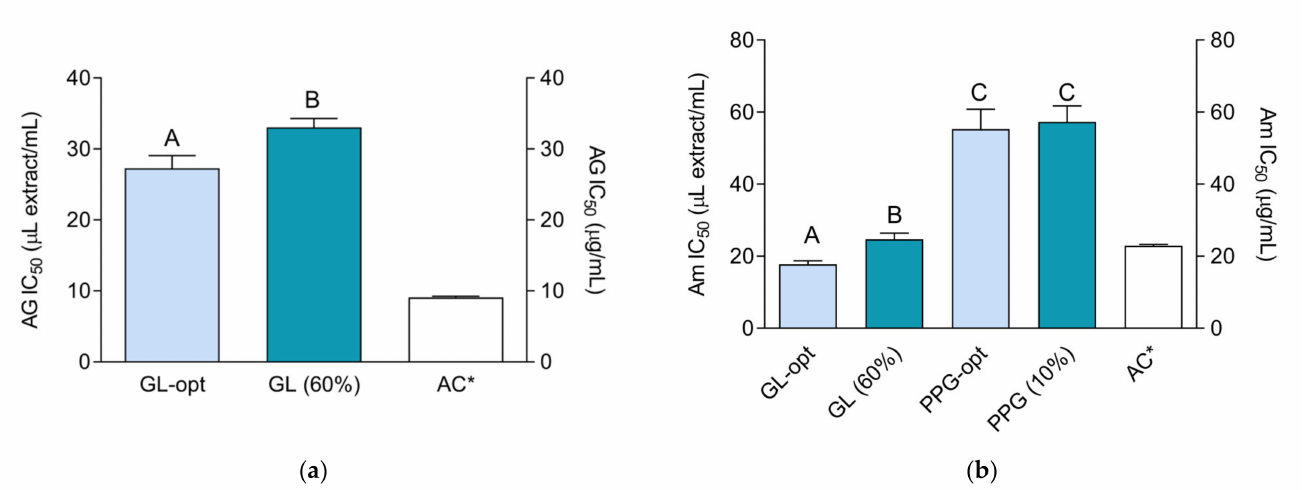
Figure 4. Antidiabetic activity of the extracts and positive control acarbose (AC): ( a ) α -glucosidase-inhibiting activity (AG); ( b ) α -amylase-inhibiting activity (Am). The activity is expressed as IC 50 value. Asterisk (*) indicates that the IC 50 unit is placed on the right y -axis. Different uppercase letters indicate statistically significant difference ( p <